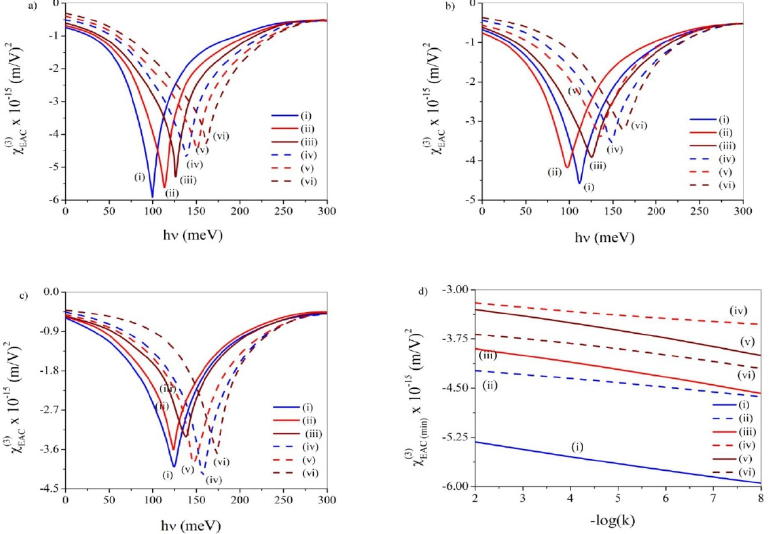
Figure 11. EAC vs. h υ diagrams ( a ) devoid of noise, ( b ) under ADWN and ( c ) under MLWN. In these diagrams the anharmonicity has (i) odd parity and k = 10 − 8 , (ii) odd parity and k = 10 − 5 , (iii) odd parity and k = 10 − 2 , (iv) even parity and k = 10 − 8 , (v) even parity and k = 10 − 5 , (vi) even parity and k = 10 − 2 . ( d ) Depiction of EAC minimum peak values vs. − log(k): (i) devoid of noise and OPA, (ii) devoid of noise and EPA, (iii) with ADWN and OPA, (iv) with ADWN and EPA, (v) with MLWN and OPA and (vi) with MLWN and EPA. Under applied ADWN, both with OPA and EPA the EAC peaks initially display red- shift with an increase in k up to k ~10 − 5 pursued by blue-shift as k is increased beyond. The peak height depicts steadfast fall (in absolute sense) as k increases.